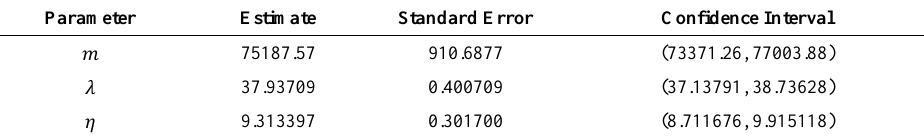
Table A7. Lombardy. Estimates, asymptotic standard errors and 95% mCIs for the parameters of the LOG model (2).